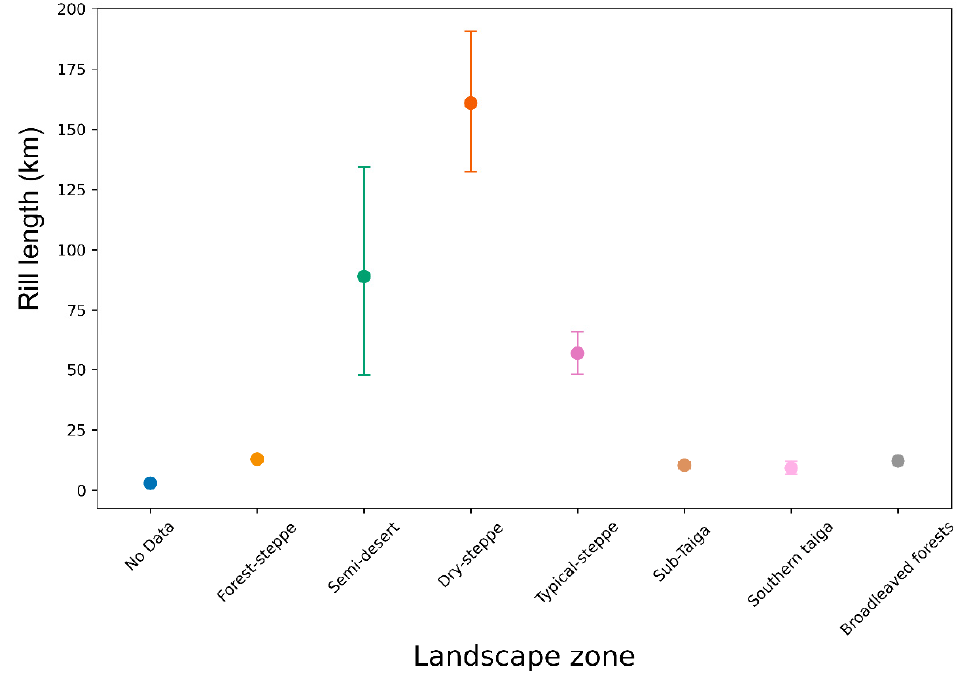
Figure 19. Relationship between the rill erosion network length and landscape zone. The analysis of the relationship between erosion processes and anthropogenic load also confirms the previous conclusions (Figure 20). The score of the anthropogenic load is given based on the development of the territory, the presence of settlements, industry, and roads of various types, as well as population density.